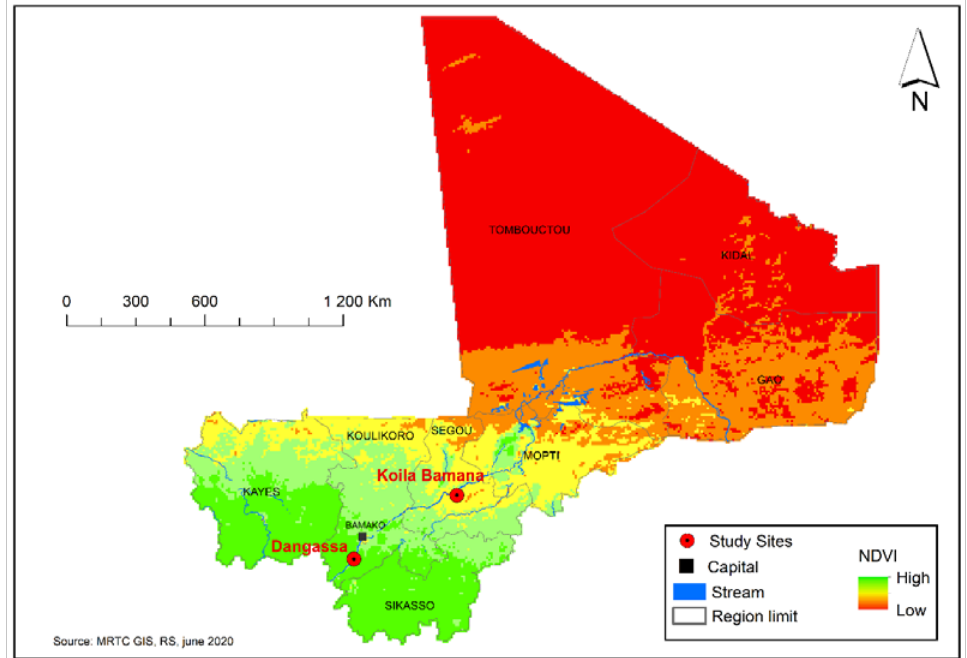
Figure 1. Study sites: shapefiles have been obtained from the Mission of Decentralization and Institutional Reform of Mali (MDRI). The map was based on the cartography of Mali, the mean Normalized Difference Vegetation Index (NDVI) reported downloaded as rasters from the National Aeronautics and Space Administration (NASA) Giovanni on a time period going from 22 June 2015 to 6 January 2017.